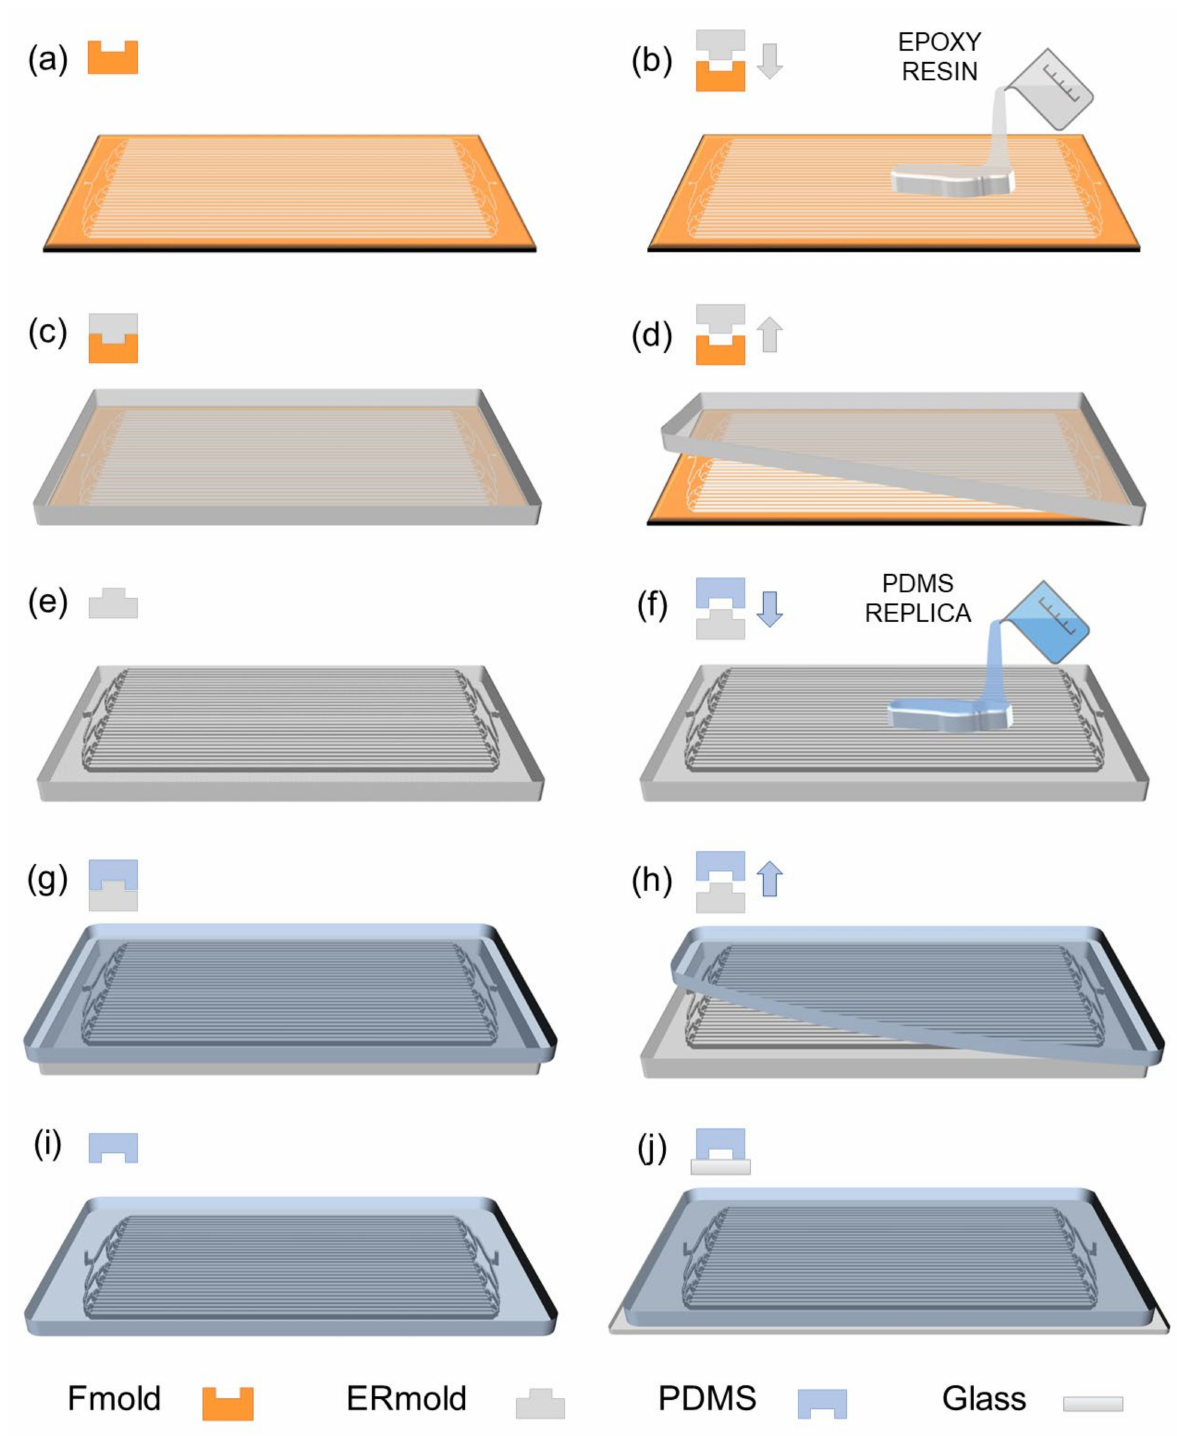
Figure 1. PDMS LM bioreactor device fabrication: ( a ) Female patterned photopolymeric flexographic master mold (Fmold); ( b ) the epoxy resin layer is cast on the female Fmold; ( c ) the epoxy resin is cured at 25 ◦ C for 72 h; ( d ) the cured epoxy layer is peeled off; ( e ) the male ERmold is complete; ( f ) the PDMS replica is cast on the male ERmold; ( g ) the PDMS layer is cured at 40 ◦ C overnight; ( h ) the female PDMS replica is peeled off; ( i ) The fluidic connection entry and exit ports are punched on the female PDMS; ( j ) the PDMS replica with the design of the bioreactor microfluidic channels is irreversibly bonded by plasma exposure to a glass